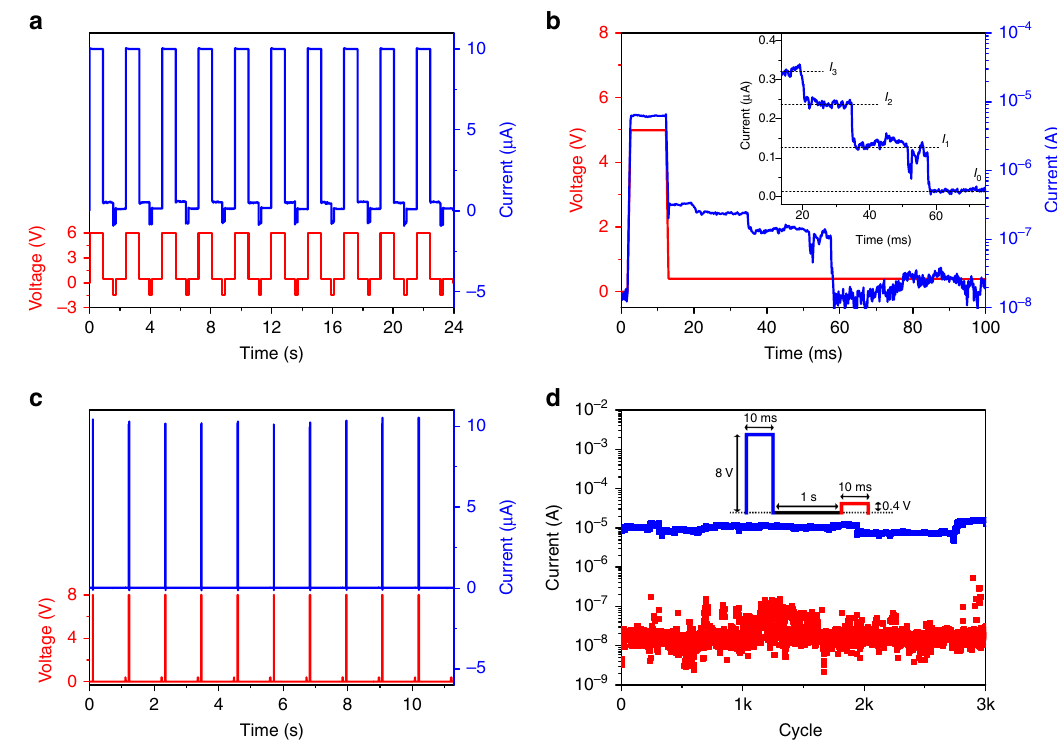
Fig. 5 AC operation modes of a single ZnO NW. a Non-volatile resistive switching behaviour observed after long writing pulses. Long write pulses (6 V, 880 ms) were applied to SET the device (CC = 10 µ A) while erase pulses ( − 1.5 V, 180 ms) were applied to RESET the device. Current was measured at a reading voltage of 0.5 V. b Volatile resistive switching observed after shorter writing pulses. After a relatively short programming pulse (5 V, 10 ms), the device spontaneously relaxes back to the HRS. After pulse, the current relaxation was measured at a reading voltage of 0.4 V. The inset shows the detail of the quantized relaxation process characterized by discrete current steps. c Threshold switching behaviour observed by applying short programming